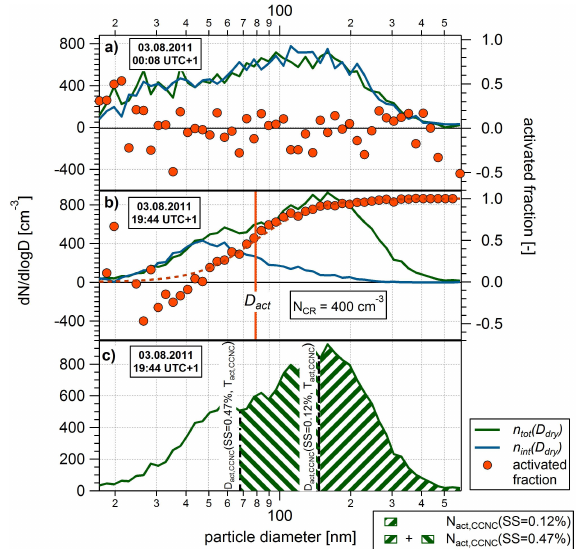
Fig. 3. Hourly averaged aerosol number size distributions measured behind the total and interstitial inlet for an out-of-cloud event (a) and a cloud event (b) . The right axis in (a) shows the calculated activated fraction for the cloud event. The median shows the activa- tion diameter where 50% of the particles acted as CCN ( D act ). The dashed line is a hill equation fit used to derive D act . N CR is the num- ber of cloud residuals that correspond to the number of CCNs that were activated to cloud droplets at ambient conditions. In (c) a par- ticle size distribution is shown with integrating from its upper end until the integrated area is equal to the number of CCN measured in the CCNC. This results in the activation diameter corresponding to the set SS in the CCNC ( D act,CCNC ( SS set )